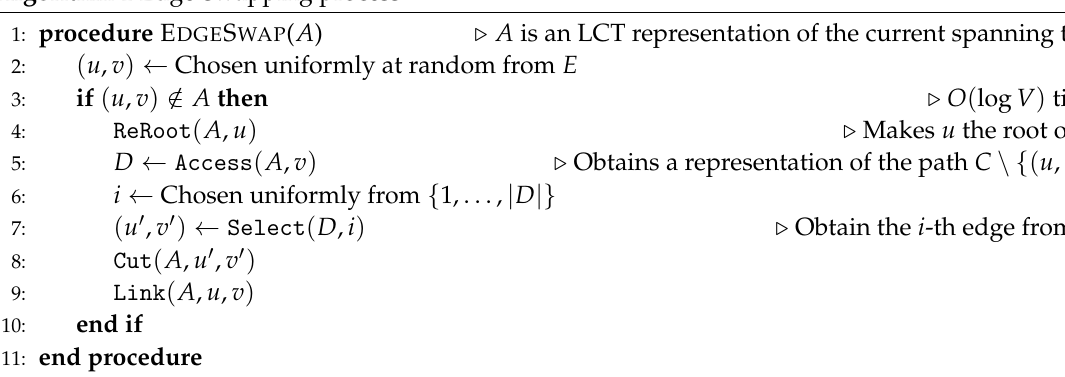
Algorithm 1 Edge-swapping